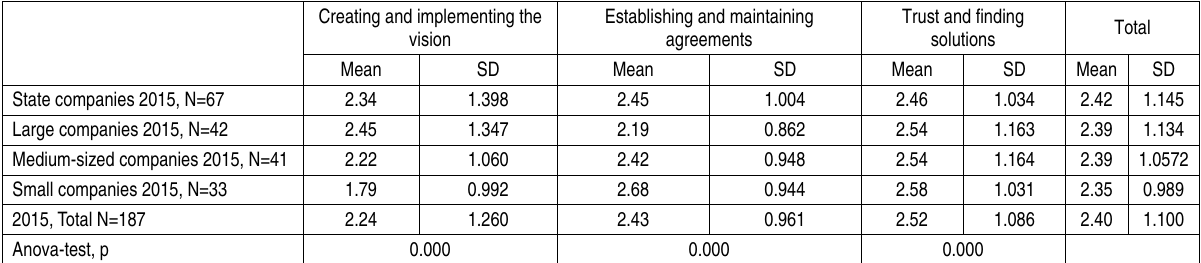
Table 4. Characteristics of a coaching culture in the leadership style in different types of organizations in 2015 based on the 3C model